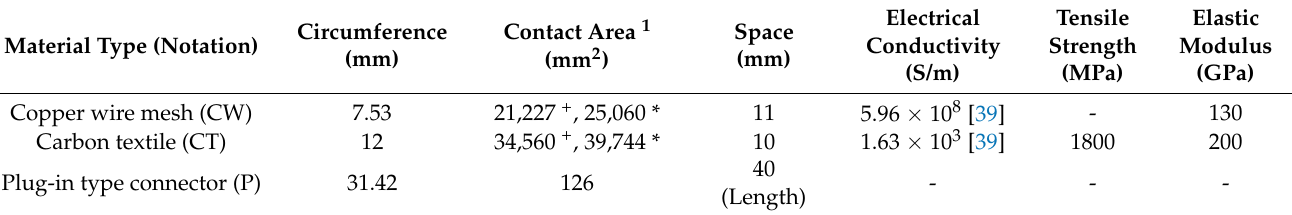
Table 2. Properties of electrode materials.